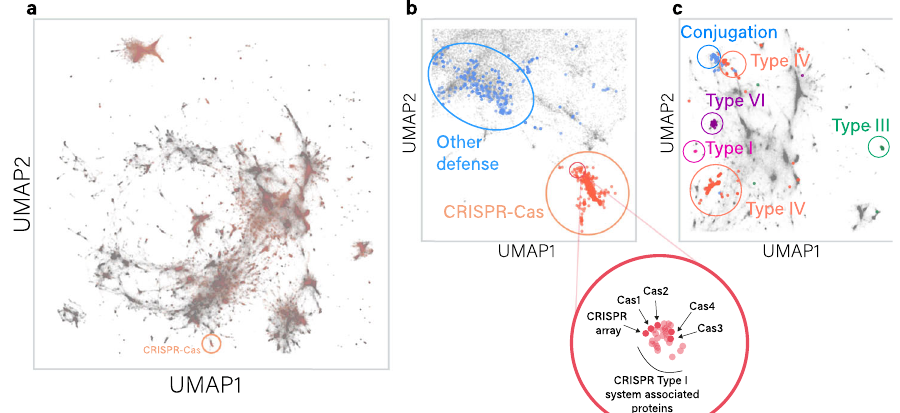
Fig. 2 | A two-dimensional representation of the space spanned by gene annotation embeddings. a Global gene embedding space, including all 563,589 gene families. Each dot in the space represents a gene family, where light red dots represent annotated families and gray dots represent unannotated gene families. The orange circle marks the region that contains most CRISPR-Cas genes (magni- fi ed in panel b alongside other defense genes). b Regions of defense systems